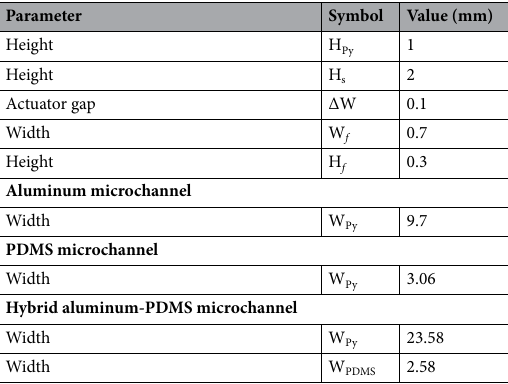
Table 6. Geometrical parameters of different microchannels used in this acoustophoretic